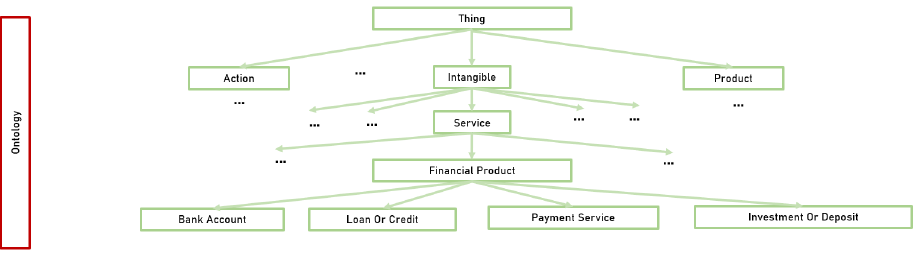
Figure 3. Excerpt of the Schema.org Reference Ontology imported within the RADAR Data Model for the running